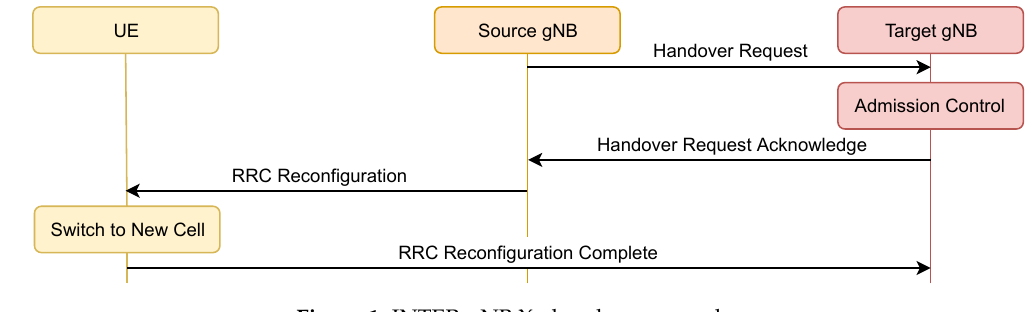
Figure 1. INTER-gNB Xn handover